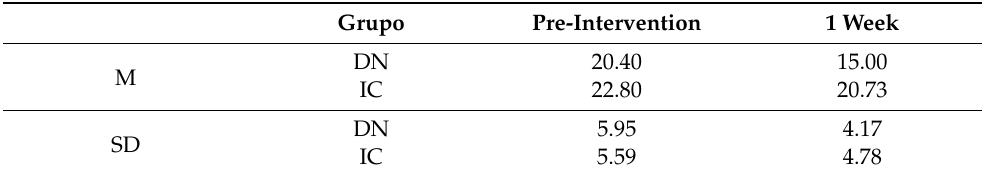
Table 7. Mean (M) and standard deviation (SD) of the Oswestry questionnaire, according to group, and the time of completion of the